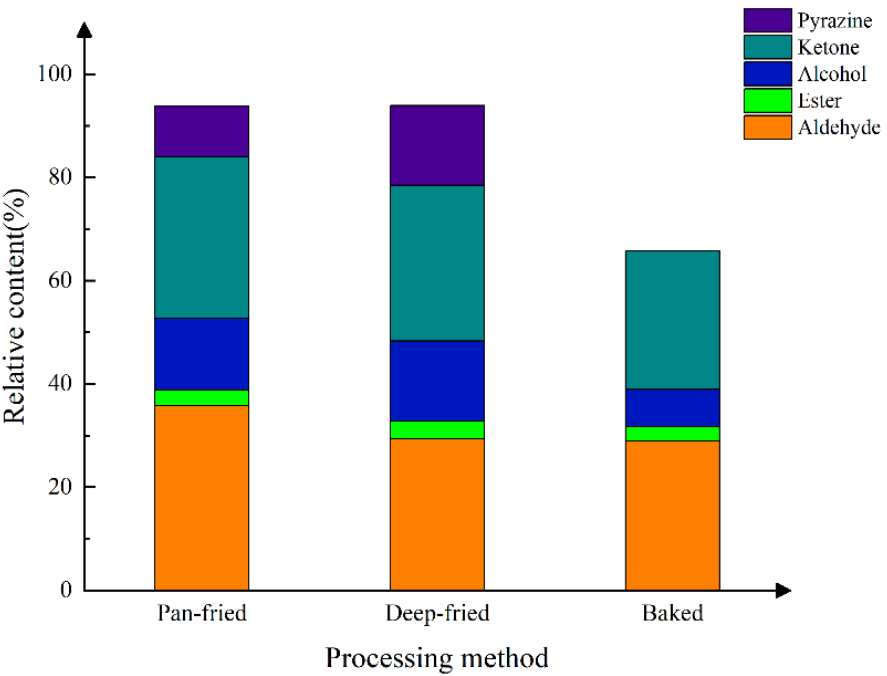
Figure 7. Relative contents of various flavor substances in BTS meat processed by different methods.